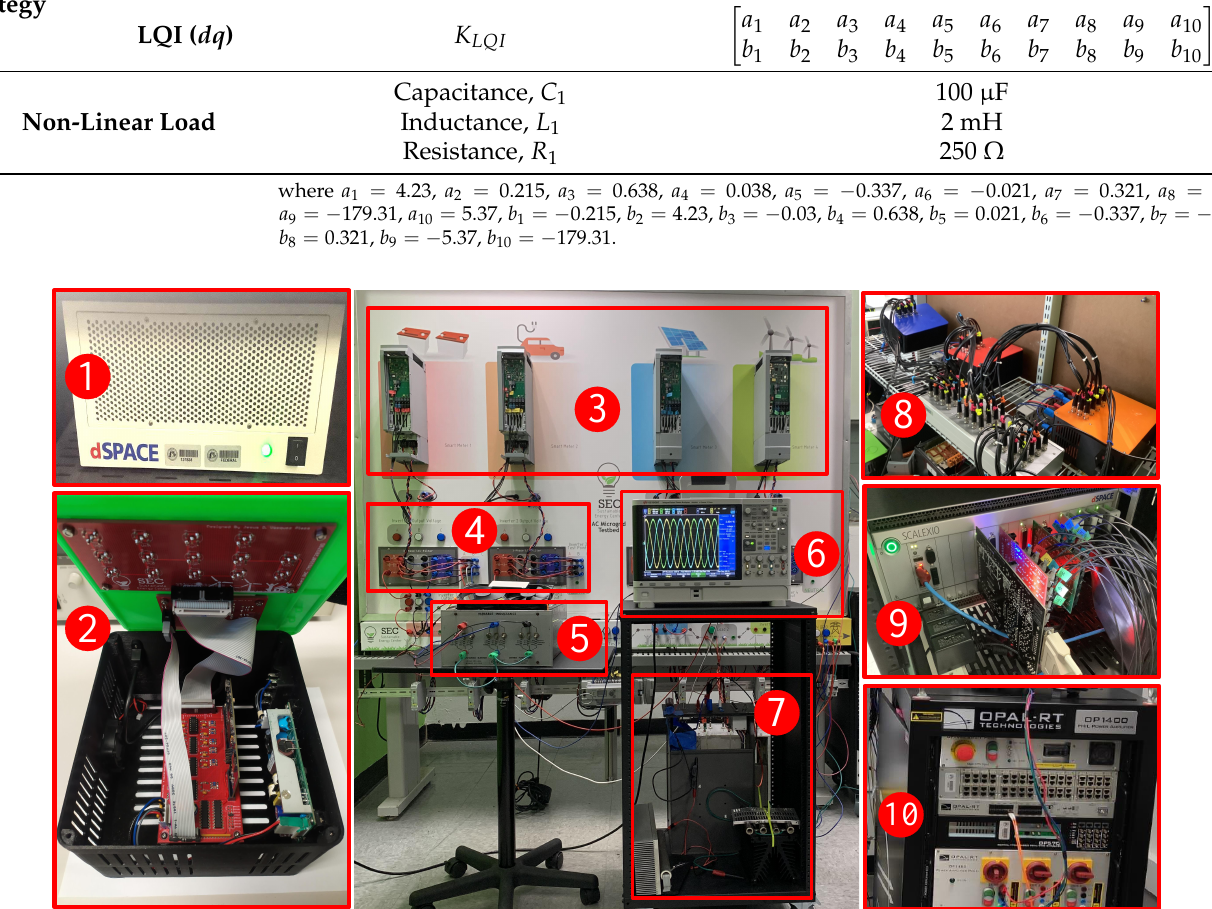
Figure 10. Microgrid Experimental Platform. 1—dSPACE 1006, 2—TI µ C C2000 F28379D, 3—Danfoss 2.2 kVA DC/AC SPCs, 4—LCL output filters, 5—linear load, 6—PA2203A KEYSIGHT Power Ana- lyzer, 7—non-linear load, 8—sensor boxes, 9—dSPACE-Scalexio, 10—OPAL-RT